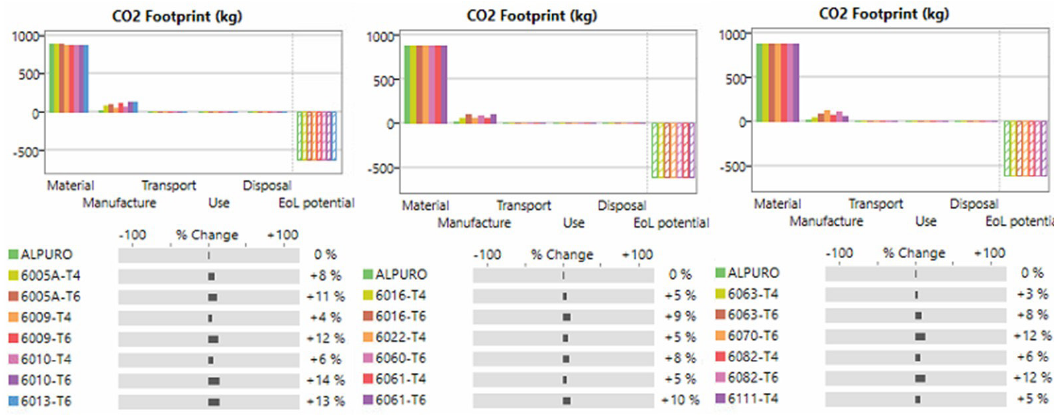
footprint in the production and manufacturing of the 6000 series alloys. Images used are courtesy of ANSYS, Figure 8. CO 2